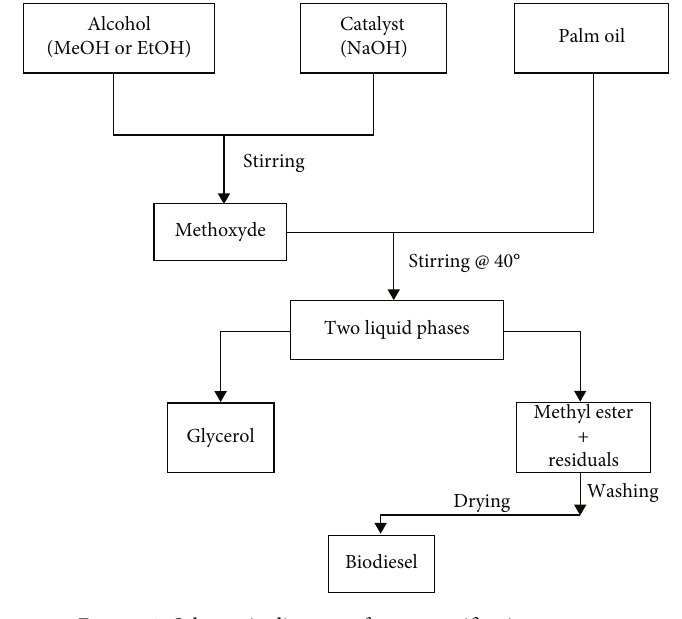
Figure 1: Schematic diagram of transesteri fi cation